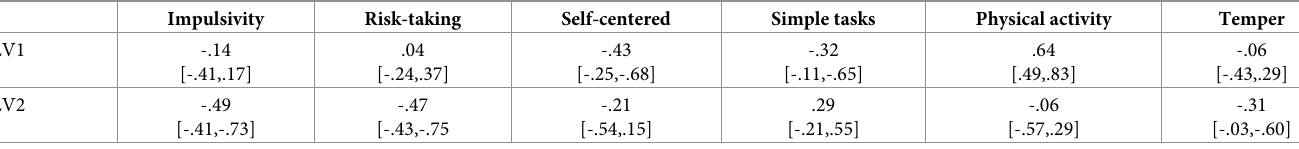
Table 4. Brain-behavior correlations with 95% confidence intervals for the six subscales of self-control and ERP activity. Impulsivity